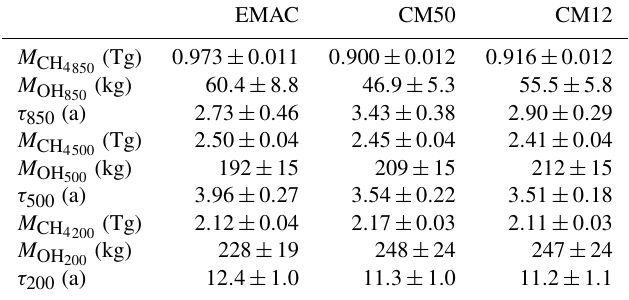
Table 6. Average values for June–August 2008 of the CH 4 mass ( M CH ), the OH mass ( M OH ) and the methane lifetime against OH ( τ ) 4 for EMAC, CM50 and CM12. All values are computed for the area of the CM12 instance. The mass of CH 4 and OH are the time-averaged values. The uncertainty range is the standard deviations with respect to time (based on the monthly mean values). The subscripts on the individual variables indicate the different vertical layers.